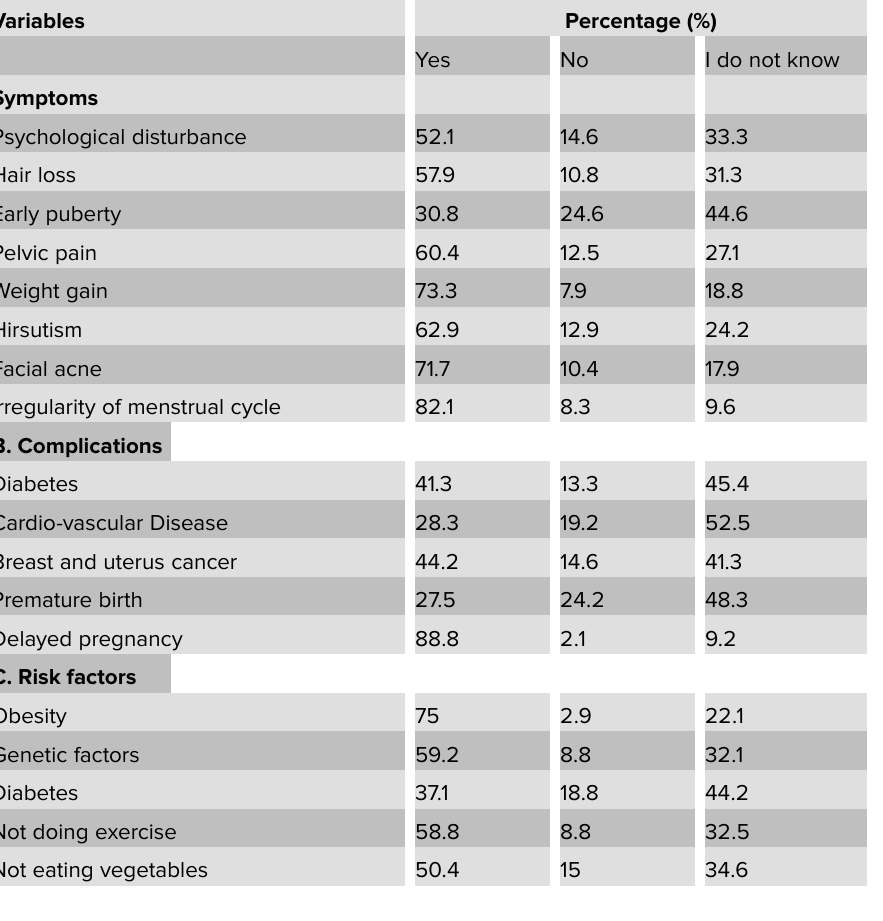
Table 2: Knowledge among studied participants about clinical features, complications, and risk factors of PCOS ( n =